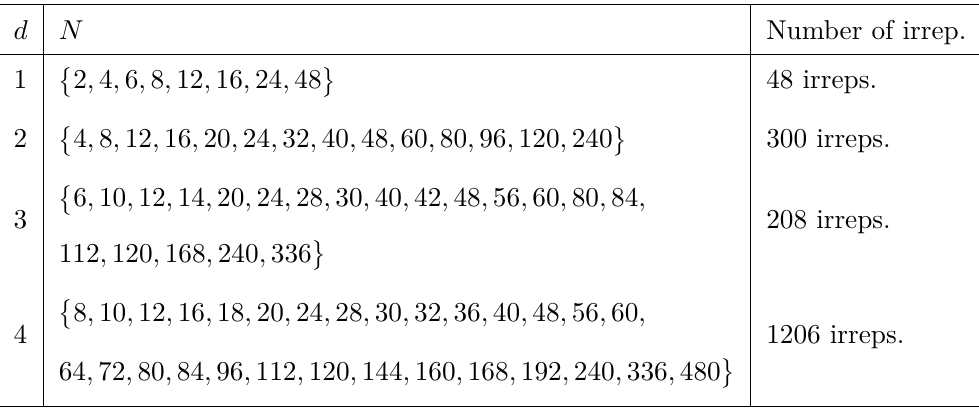
Table 1 . Complete lists of allowed values of N for FRCFTs as well as the number of possible irreducible representations when d = 1 , 2 , 3 , 4